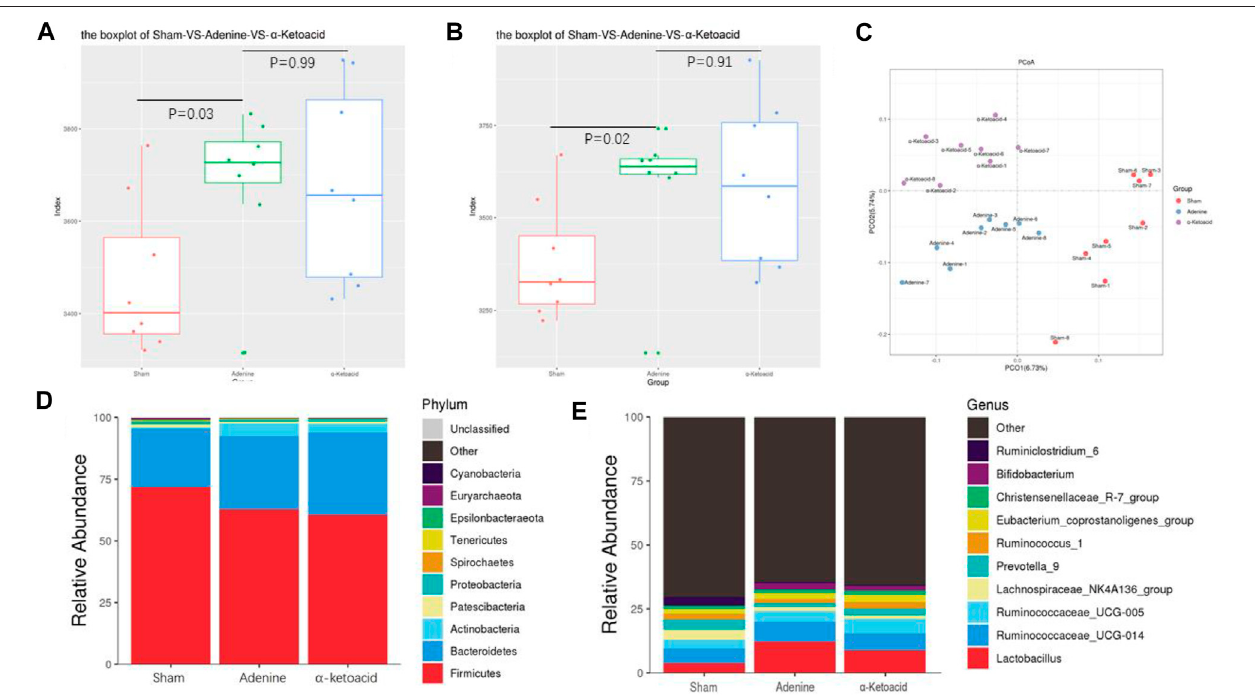
FIGURE3| Regulation of α -ketoacidongutmicrobiomeinadenine-inducedCKDrats. (A) Thechaoindexof α -diversity. (B) Theaceindexof α -diversity. (C) PCoA plotsbasedonunweightedunifractocompare β -diversityofgutmicrobiota. (D) Compositionsofgutmicrobiotaatthephylumlevel. (E) Compositionsofgutmicrobiotaat the genus